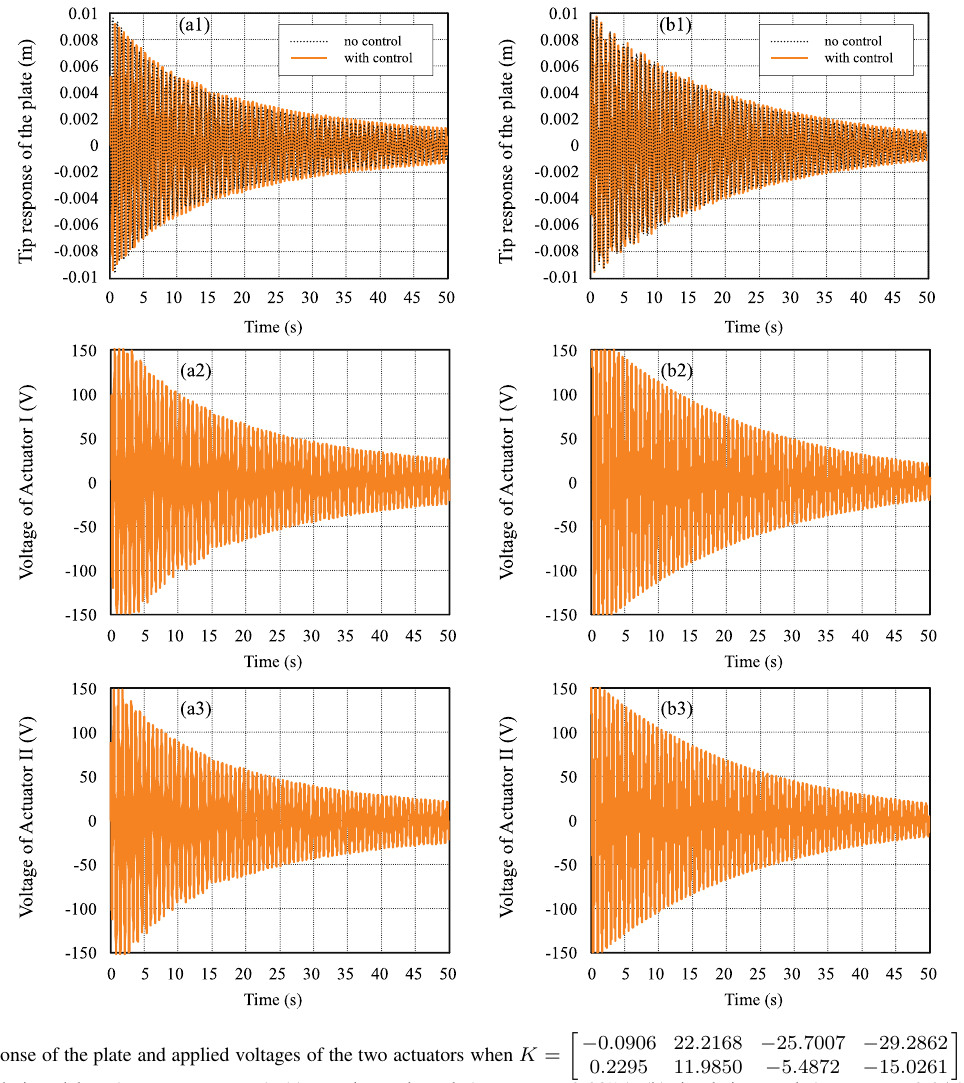
Fig. 8. Response of the plate and applied voltages of the two actuators when K =